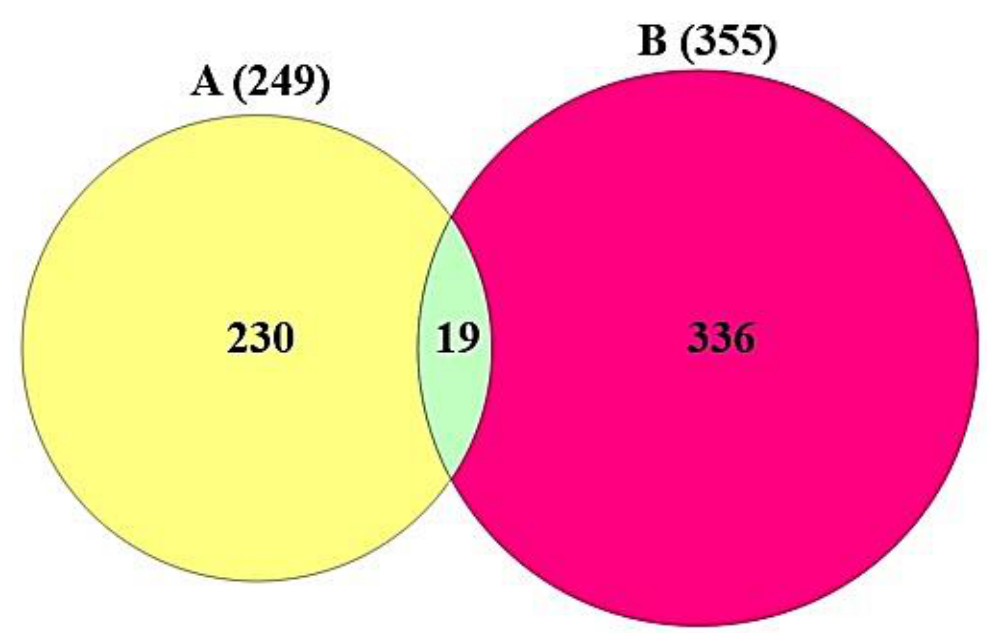
Figure 3. The final 19 targets between the 249 targets and 355 COVID-19 targets.